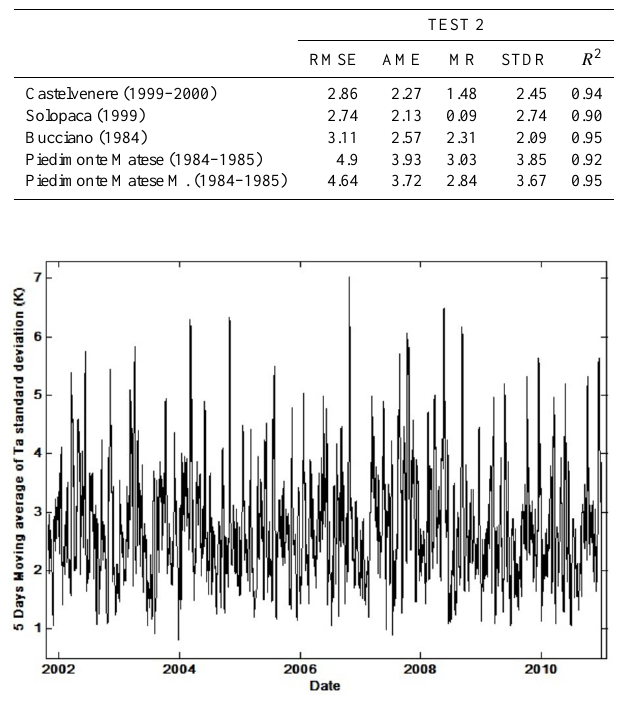
Fig. 10. Five-day moving average standard deviation of observed T a at Guardia Sanframondi station.